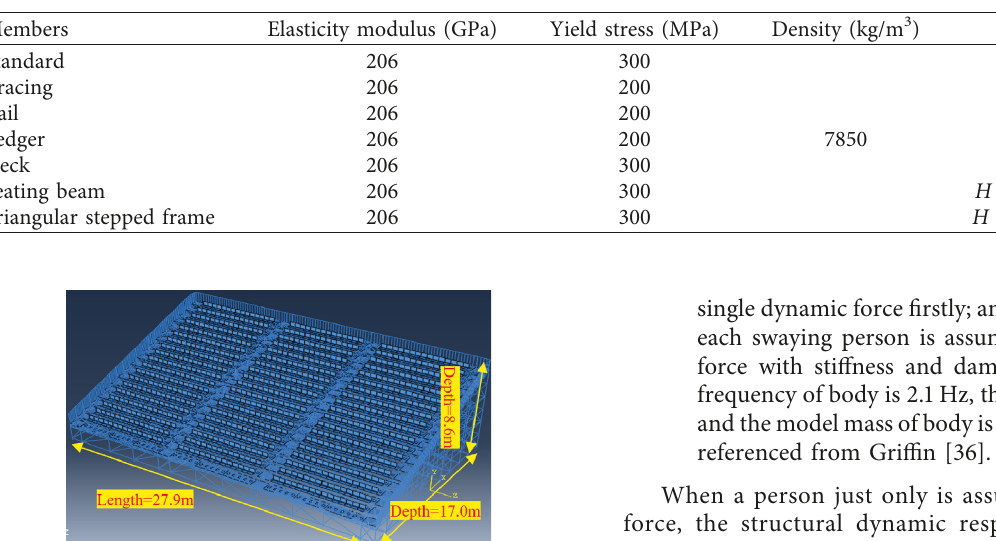
Figure 16: The structural acceleration peak value, RMS, and VDV relationship with crowd swaying frequencies. (a) Structural acceleration curve of seated crowd with 1.8Hz swaying and (b) three measures acceleration against crowd swaying frequencies. Table 9: Material properties and members size of model.